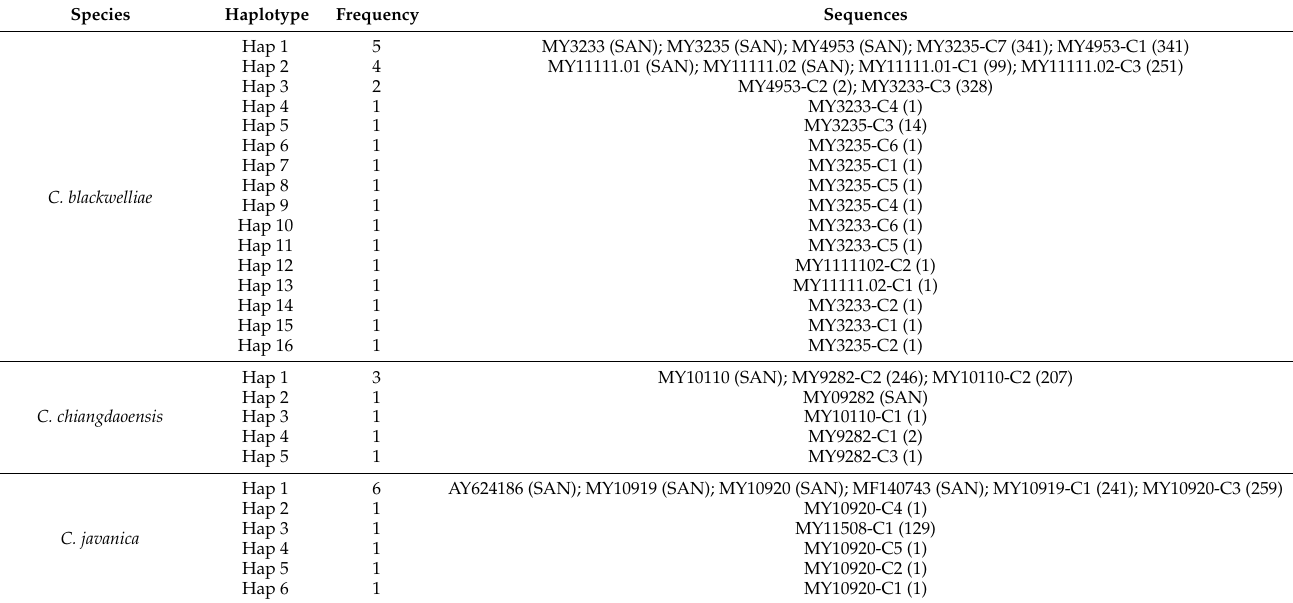
Figure 5. Haplotype network of Cordyceps species: ( a ) C. blackwelliae ; ( b ) C. chiangdaoensis ; ( c ) C. javanica ; ( d ) C. kiburiensis ; ( e ) C. lepidopterorum ; ( f ) C. morakotii ; ( g ) C. cf. ninchukispora ; ( h ) C. tenuipes . Green colour represents haplotypes inferred from both Sanger and PacBio sequences; Yellow colour represents haplotypes with only Sanger sequences and red colour represents haplotypes with only PacBio sequences. Table 3. Haplotype network information of eight Cordyceps species. SAN = Sanger sequence; Number of reads for PacBio clusters indicated in